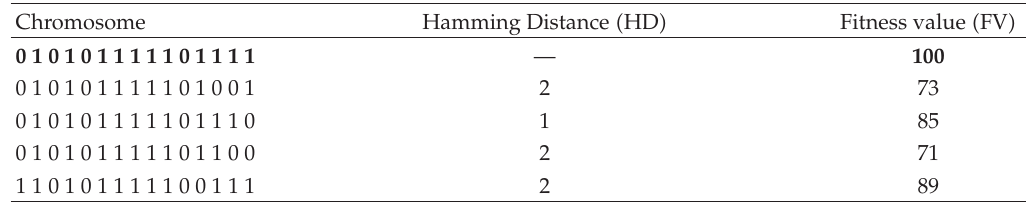
Table 1: A population with low genetic diversity based on genotype property (cid:3) HD (cid:4) but with high population diversity based on phenotype property (cid:3) FV (cid:4) . Chromosome Hamming Distance (cid:3) HD (cid:4) Fitness value (cid:3) FV